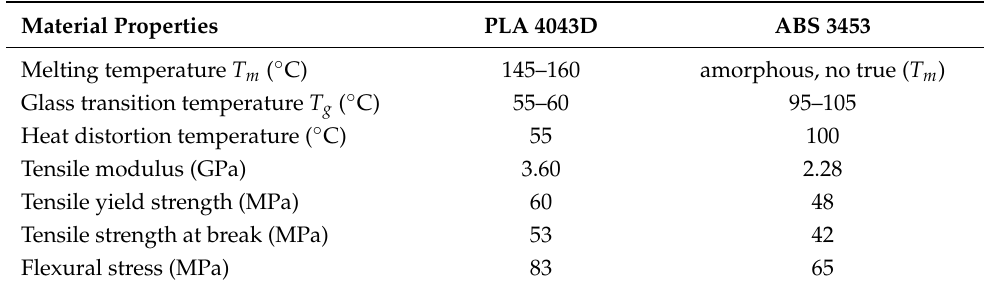
Table 1. Properties of the selected materials